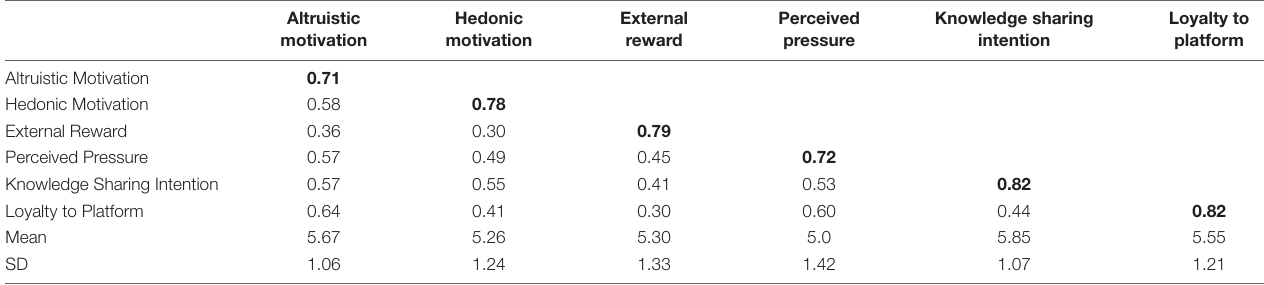
TABLE 2 | Descriptive statistics, correlations and discriminant validity